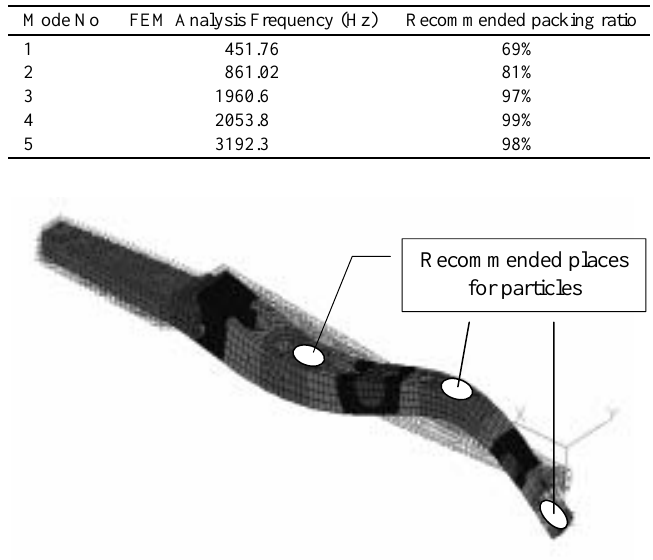
Fig. 25. Recommended locations for particles on the bond arm.